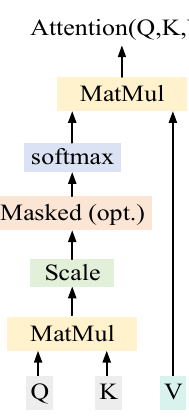
Figure 3. Attention mechanism.